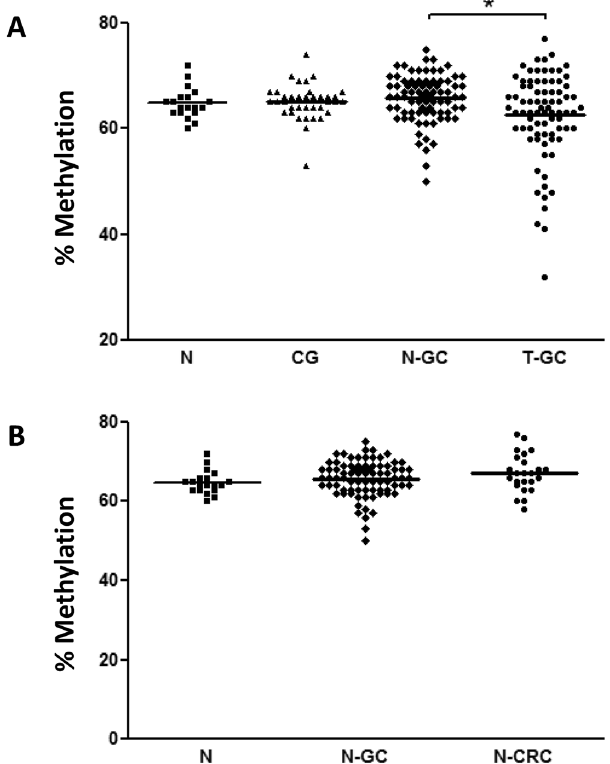
Figure 2. Quantitative LINE-1 methylation analyses in gastric and colon tissues. ( A ) LINE-1 methylation values were obtained using bisulfite pyrosequencing in gastric tissues from controls (N), patients with chronic gastritis (CG), adjacent non-tumor tissues (N-GC) and gastric cancer tumor tissues (T-GC) (p > 0.05). ( B ) LINE-1 methylation level comparison between normal gastric (N), adjacent non-tumor gastric tissues (N-GC) and non-tumoral adjacent colon tissue (N-CRC) (p = 0.2). Statistical analyses where performed using Mann- Whitney test * P <